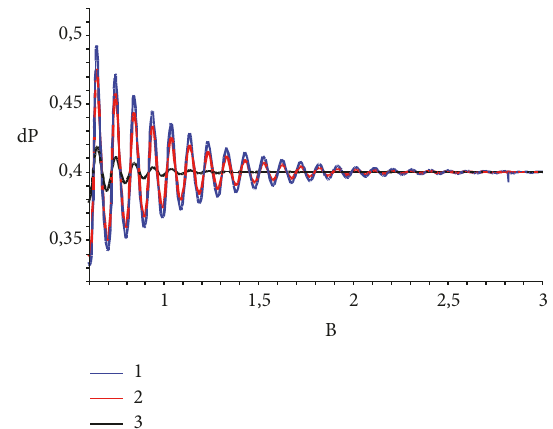
the parabolic and Kane dispersion law. Using the proposed model, the experimental results of HgSe were investigated. Using formula (10), experimental oscillations 𝑑𝑃/𝑑𝐻 in the narrow-gap semiconductor HgSe are explained at different